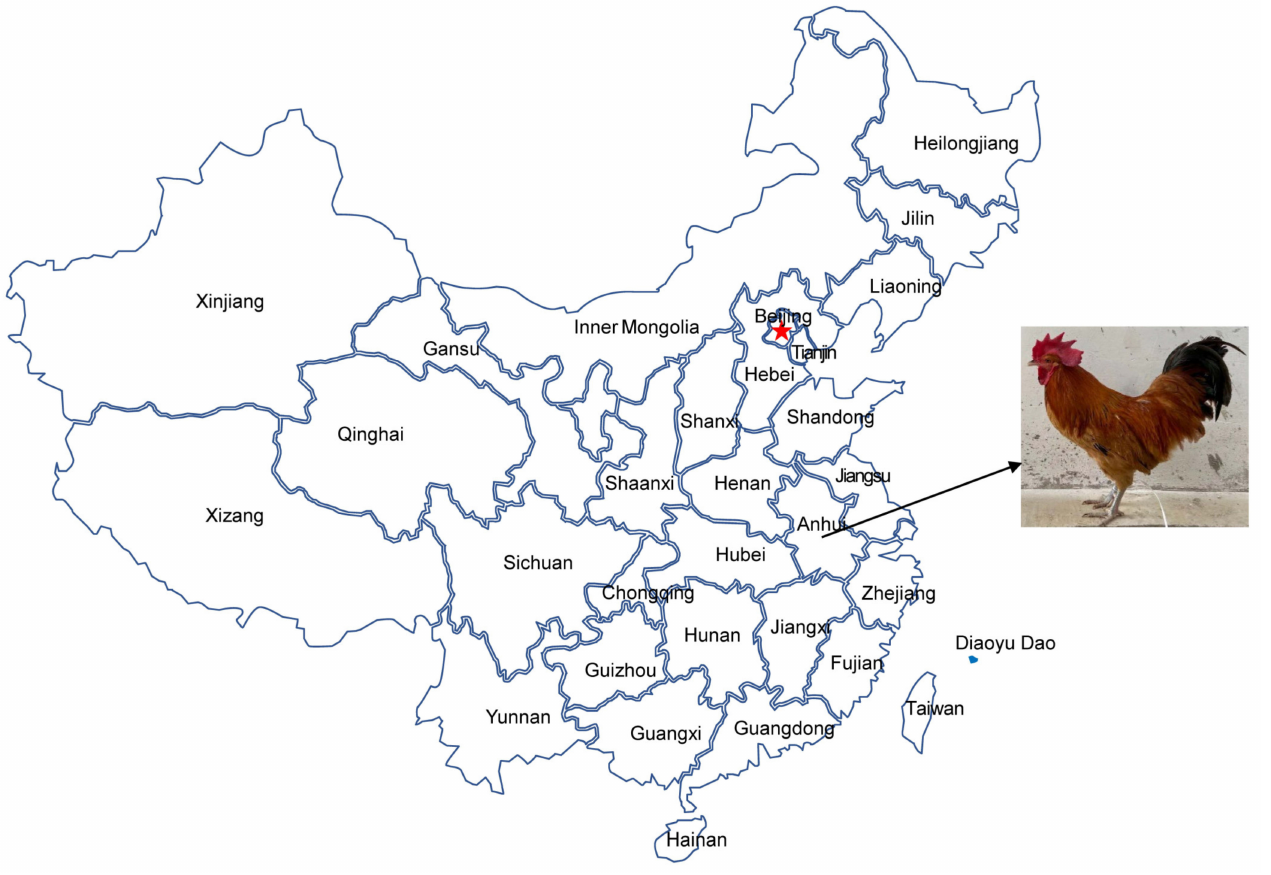
Figure 1. The geographical location of the Pingpu Yellow